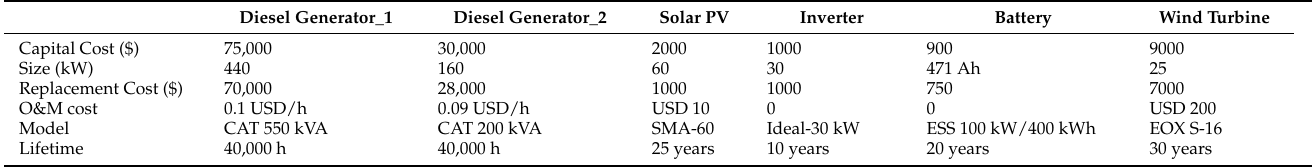
Table 2. The details of different system components used in this